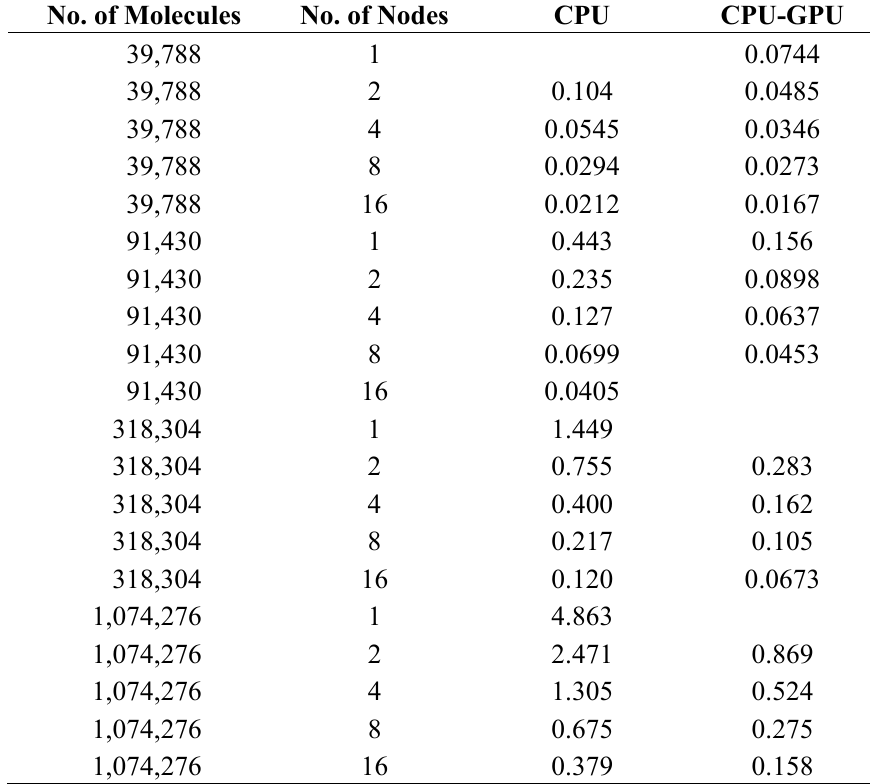
Table 1. Clock times per time step (s) for various CPU and CPU-GPU